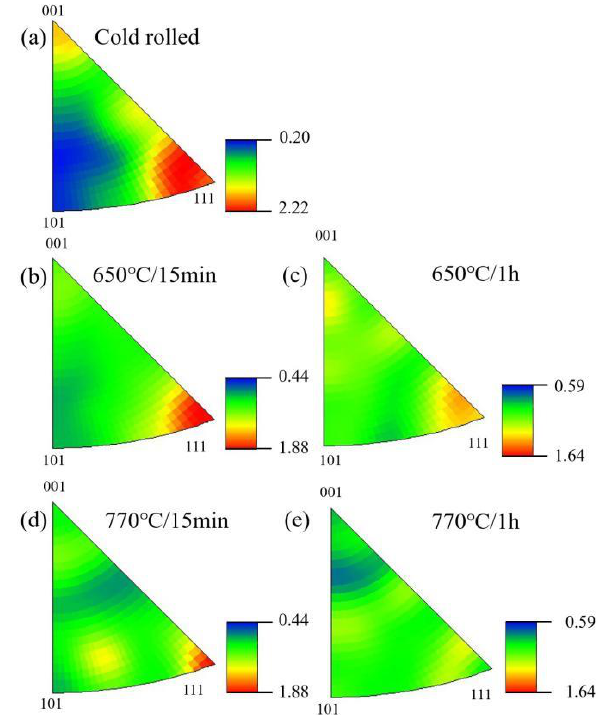
Figure 5. Inverse pole figures of cold-rolled and annealed Cu-2.7Be sheets along the normal direction (ND): ( a ) Cold rolled, ( b ) 650 °C/15 min, ( c ) 650 °C/1 h, ( d ) 770 °C/15 min, ( e ) 770 °C/1 h.